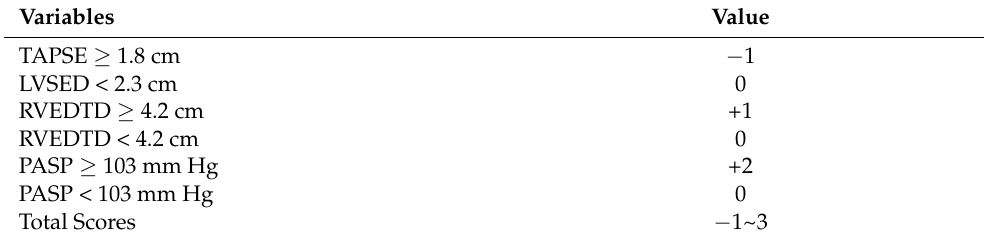
Table 3. Example of score and point allocation.